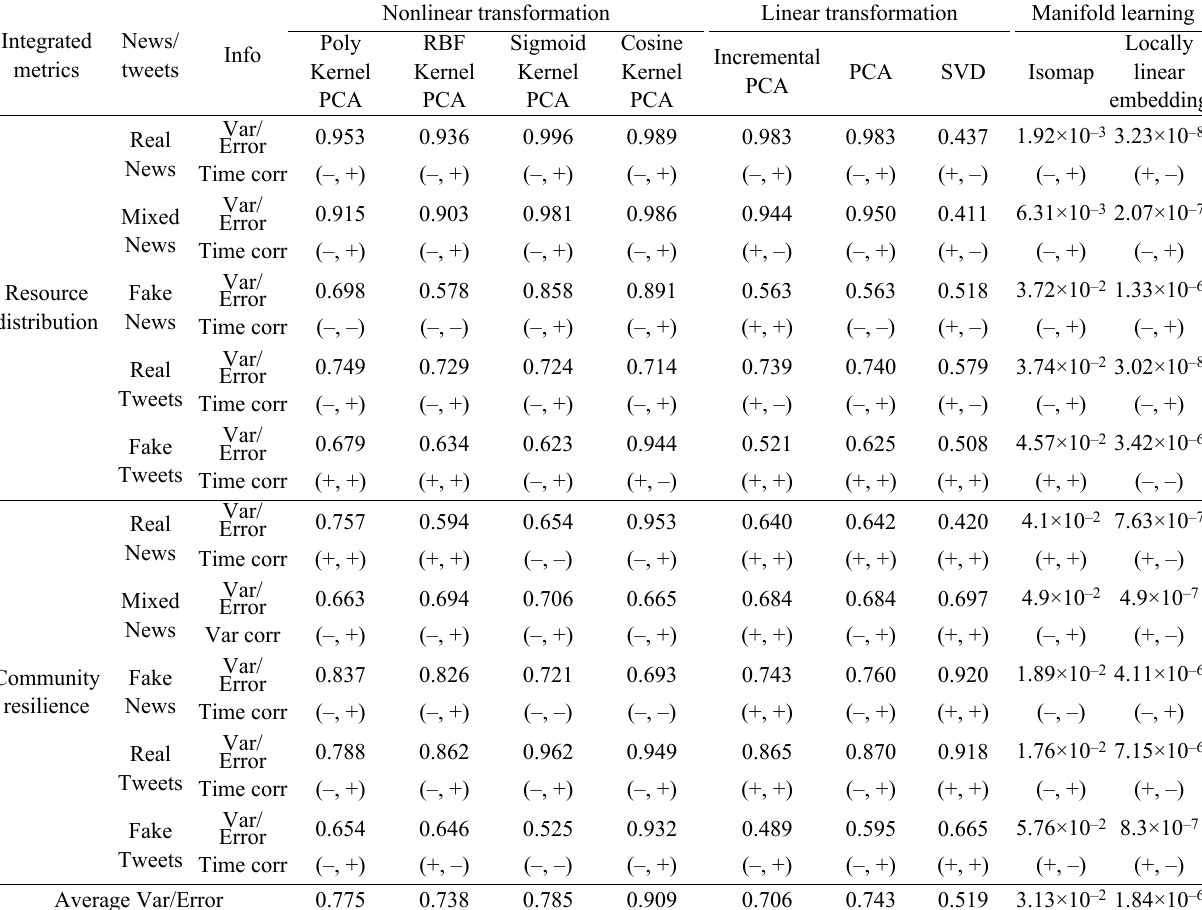
Table 1 Variance information ratio (Var), reconstruction error (error), and time-related correlations (Time corr) of resource distribution and community resilience by using the polynomial (Poly) Kernel PCA, the Gaussian radial basis function (RBF) Kernel PCA, the sigmoid Kernel PCA, the cosine Kernel PCA, the incremental PCA, the linear PCA, the SVD, the isomap, and the Locally Linear